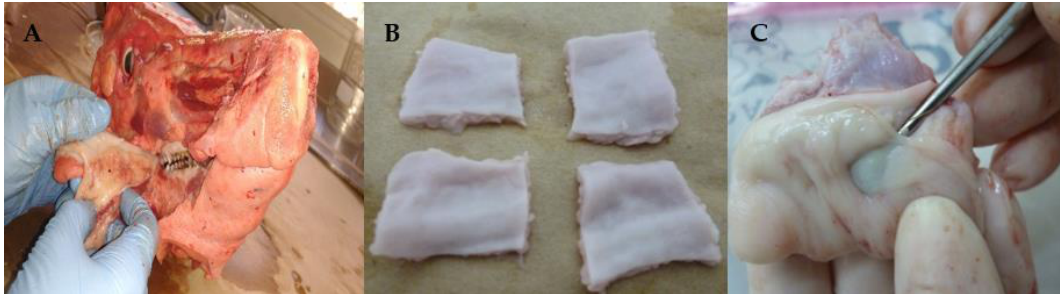
Figure 2. Buccal mucosa preparation steps: ( A ) the buccal mucosa (inner portion of the cheek) was isolated from the maxillae; ( B ) isolated buccal mucosa pieces; ( C ) detachment of the epithelium from the connective tissue.